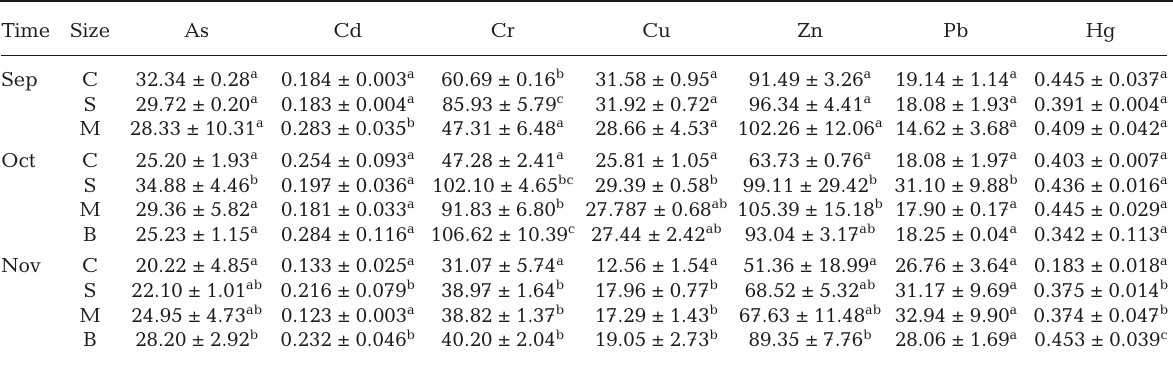
Table 6. Mean (±SD) trace element concentrations of the sediment from traps in Laizhou Bay (µg g −1 ). C: control; S: small size scallop; M: medium size; B: big size. Different letters in the same month and column indicate significant differences (p < 0.05)